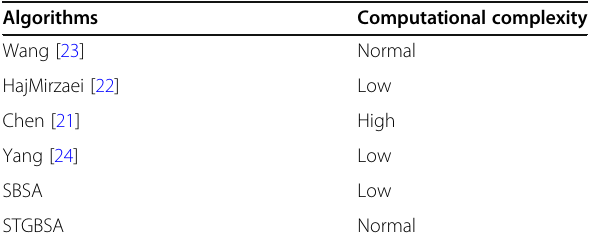
Table 2 Complexity comparison